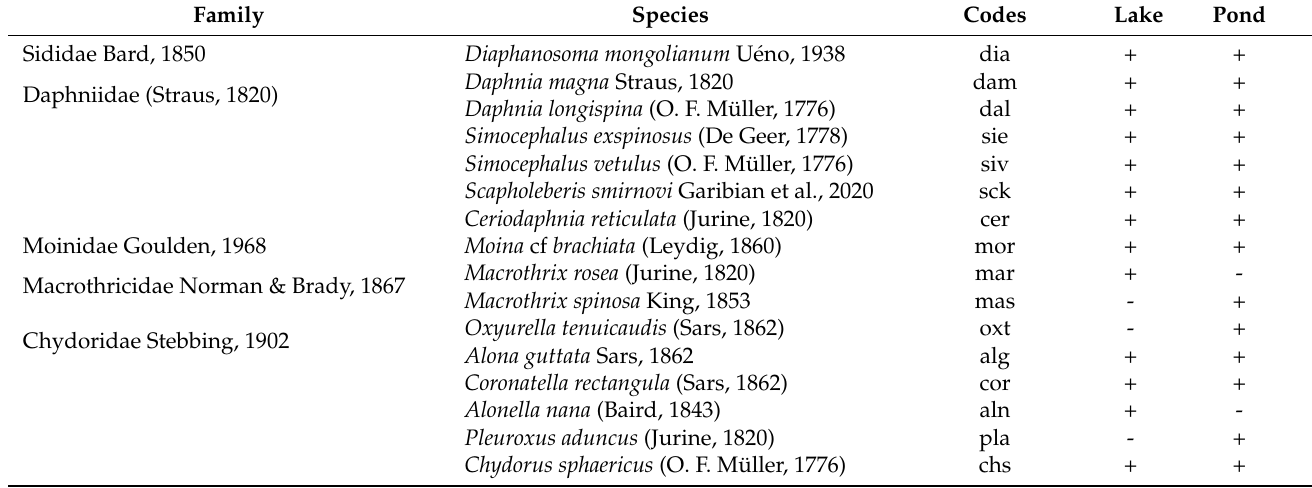
Table A1. Checklist of species from 37 sand ponds, species from 4 neighboring permanent lakes was also listed. Lake: cladoceran species present in ponds, Pond: cladoceran species present in ponds; + means present, - means absent. Family Species Codes Lake Pond Sididae Bard,